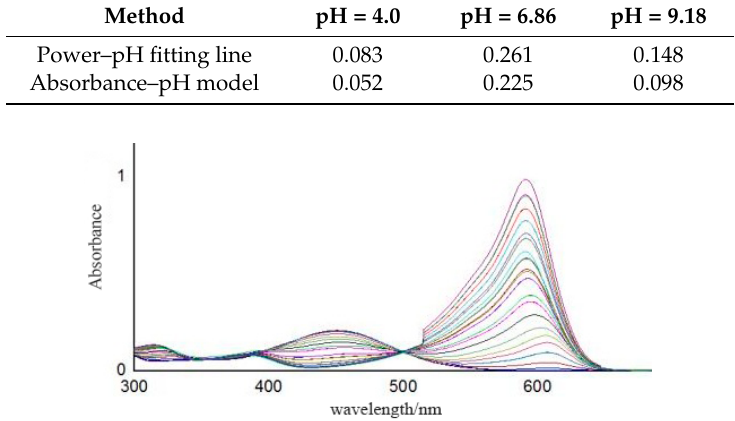
Figure 10. Absorbance spectra.